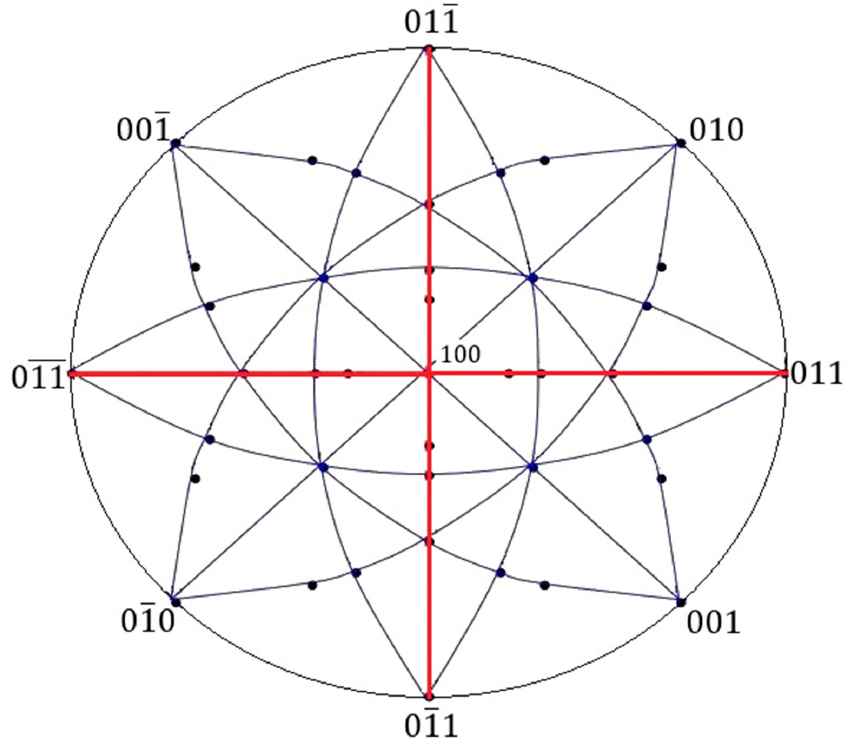
Figure 4. Stereographic projection of the (100)-oriented Si crystal.